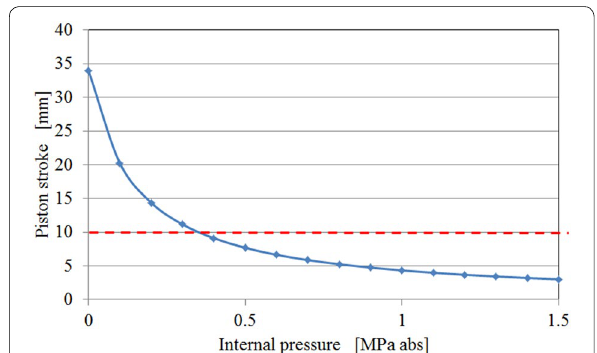
Fig. 8 Air spring internal pressure and stroke required when QRoSS V drops from a 2 [m]